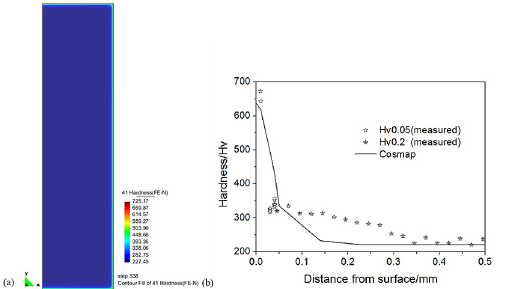
Figure 7. Simulated hardness results by